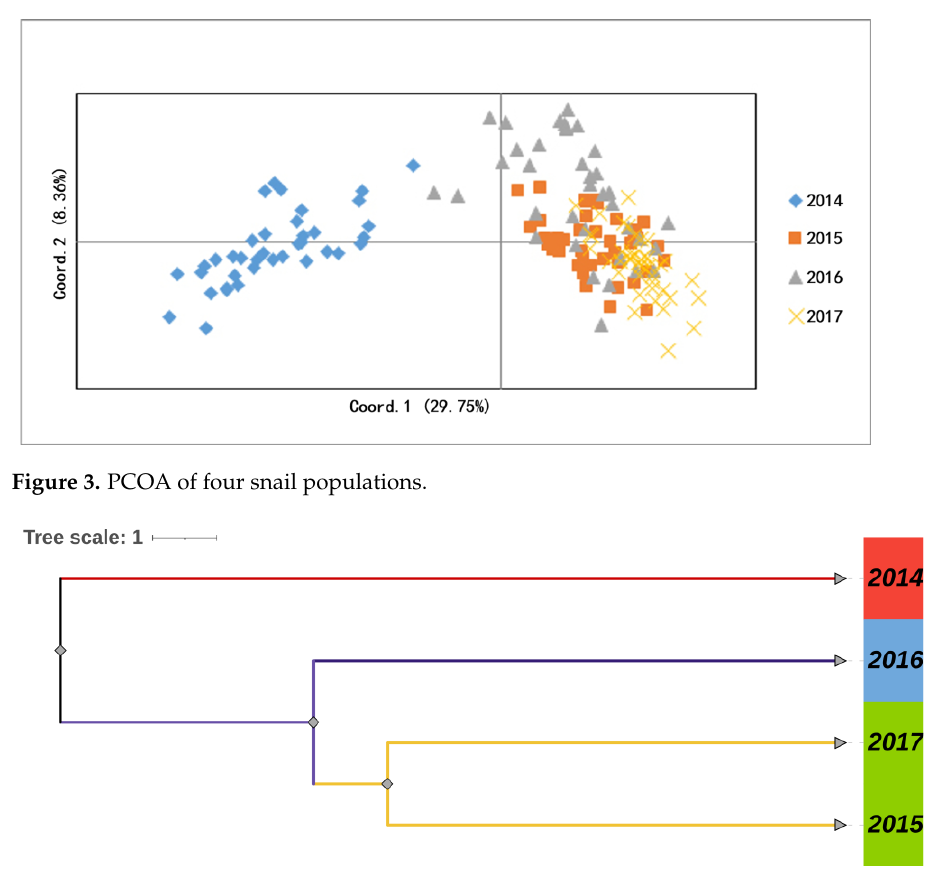
Figure 4. UPGMA tree of four snail populations.